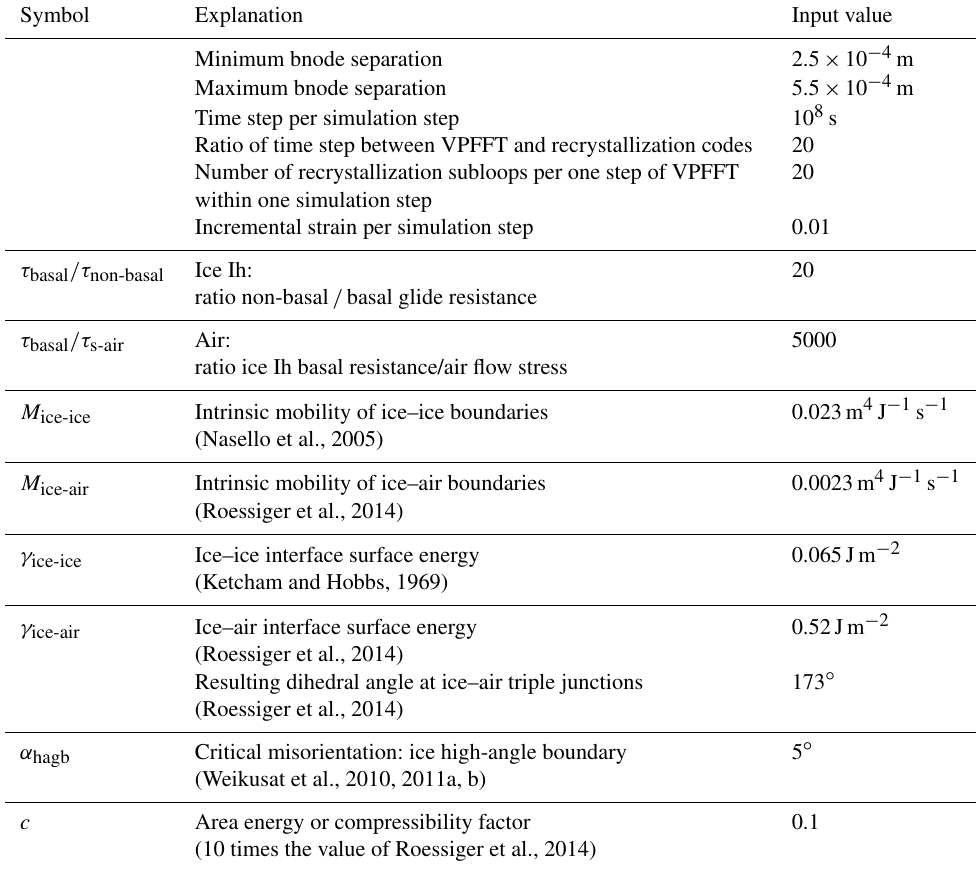
Table 1. Input properties for the simulations F00, F05 and F20. Remaining input properties according to Llorens et al. (2016, Table 1). A more detailed description of the parameters is provided in Sects. 2.4 and 2.6 and Llorens et al. (2016a,